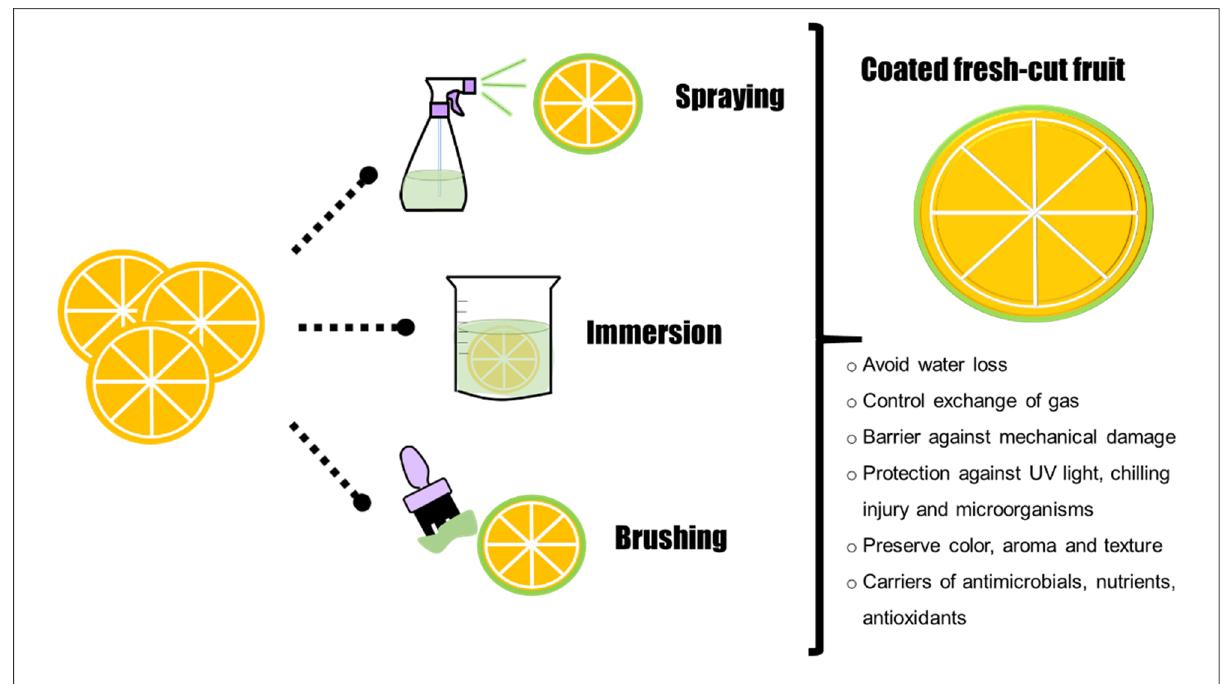
Figure 3. Main goals of edible coatings and how they are applied to fresh-cut fruits.